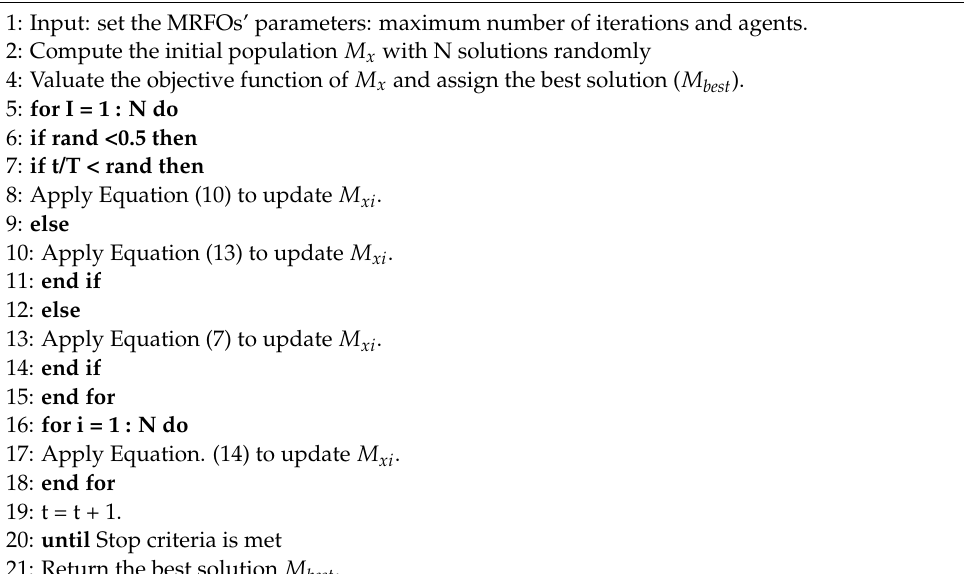
Algorithm 1 Pseudo code of the proposed